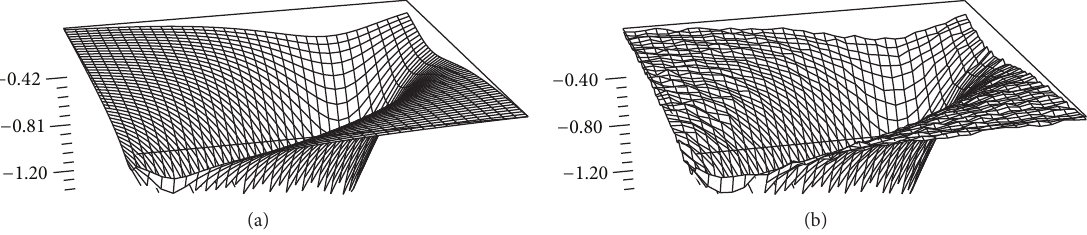
Figure 17: Zooming the component of the vector 𝐺 𝑧 , (a) calculated in double precision, (b) calculated in single precision. We can observe clearly the roughness introduced by the single precision.